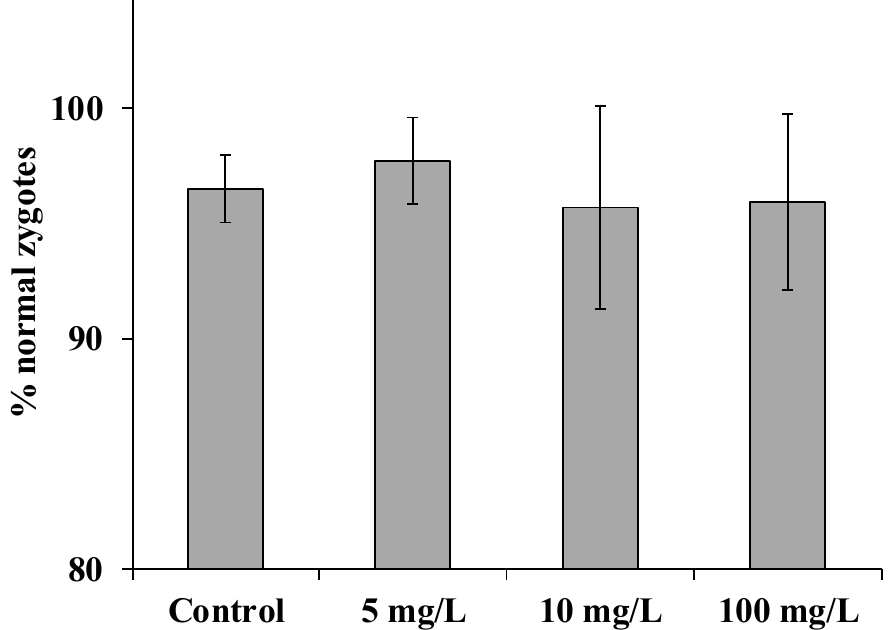
Figure 2. Fertilization success of S. mirabilis eggs by sperm exposed by different concentrations of SiO 2 NPs (mean ± standard deviation).